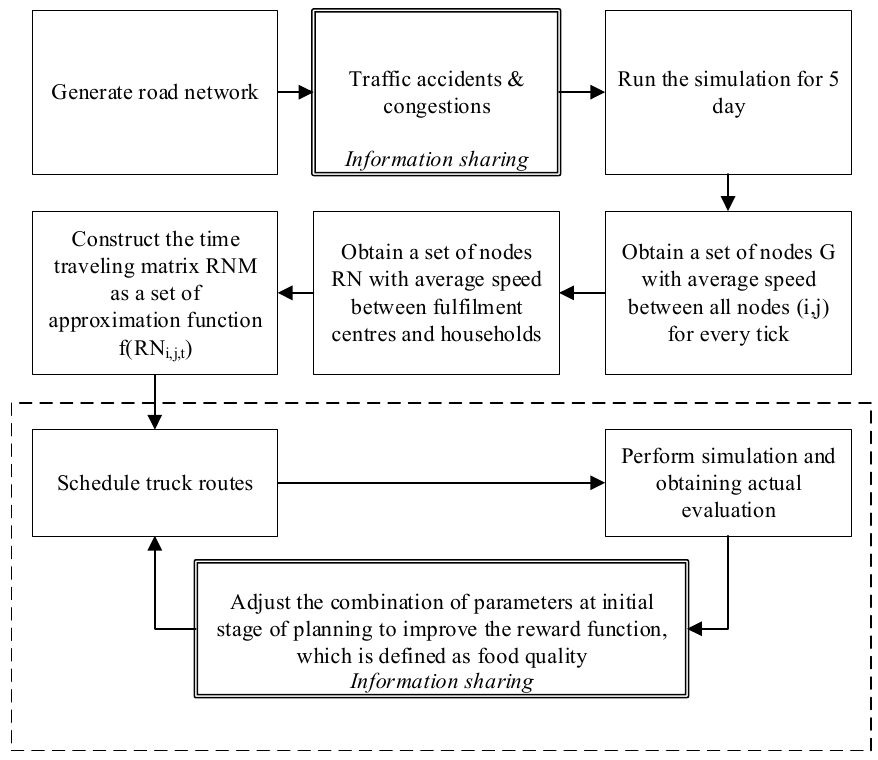
Figure 5. Route-scheduling process of information sharing and no information